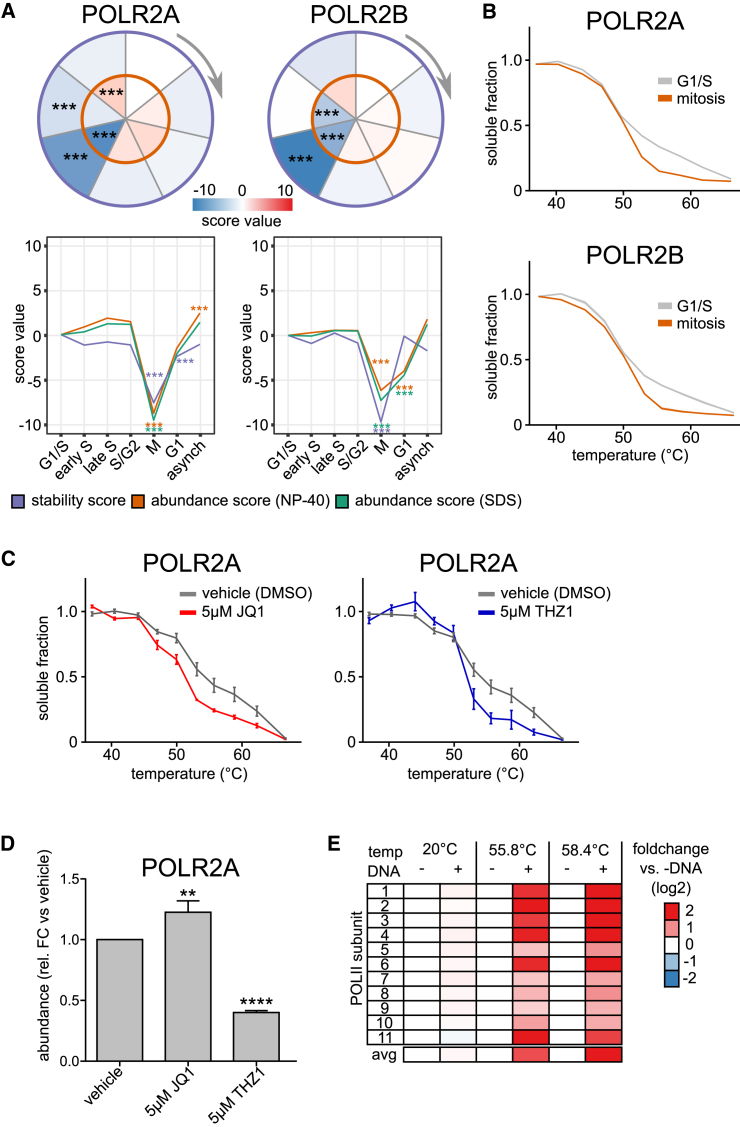
Thermal Stability and Activity of RNA Polymerase II in Mitosis(A) Circle and line plots for two subunits of RNA Pol II (POLR2A and POLR2B) show the significant change in stability (purple) and abundance (NP-40, orange, SDS green).(B) Melting curves (generated in TPP-TR experiments) for POLR2A and POLR2B show the biphasic melting behavior in G1/S, compared with mitosis.(C) TPP-TR experiment of HeLa cells treated with vehicle (DMSO), BET inhibitor JQ1, or CDK7 inhibitor THZ1. Quantified western blot data for POLR2A. SEM is shown.(D) Quantification of POLR2A protein level after a 3-hr treatment with DMSO, JQ1, or THZ1 (western blot quantification). SEM is shown.(E) Stabilization of purified RNA Pol II complex from yeast by its specific DNA sequence. The stabilization was calculated as a fold change against the control (without DNA) for each temperature. Coomassie gel quantification.See also Figure S4 and Tables S2, S3, and S4.